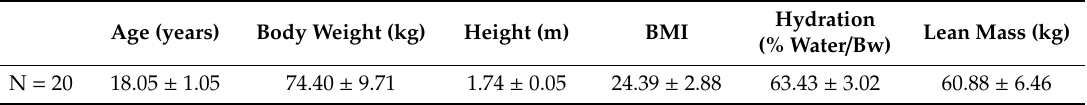
Data are presented as the mean (M) and ( ±